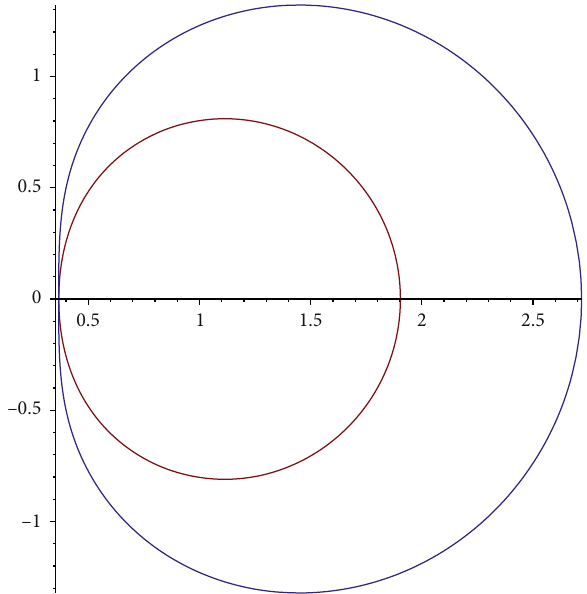
ffiffiffiffiffiffiffiffiffiffi p 1 + z .